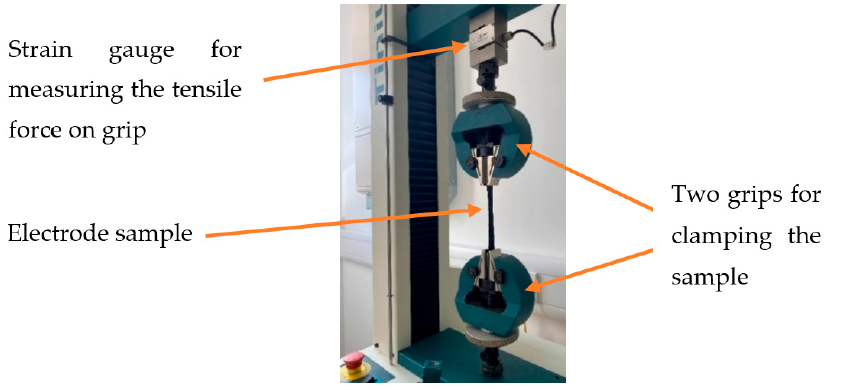
Figure 1. Tinius Olsen H25KS tensometer. An electrode sample is being measured.